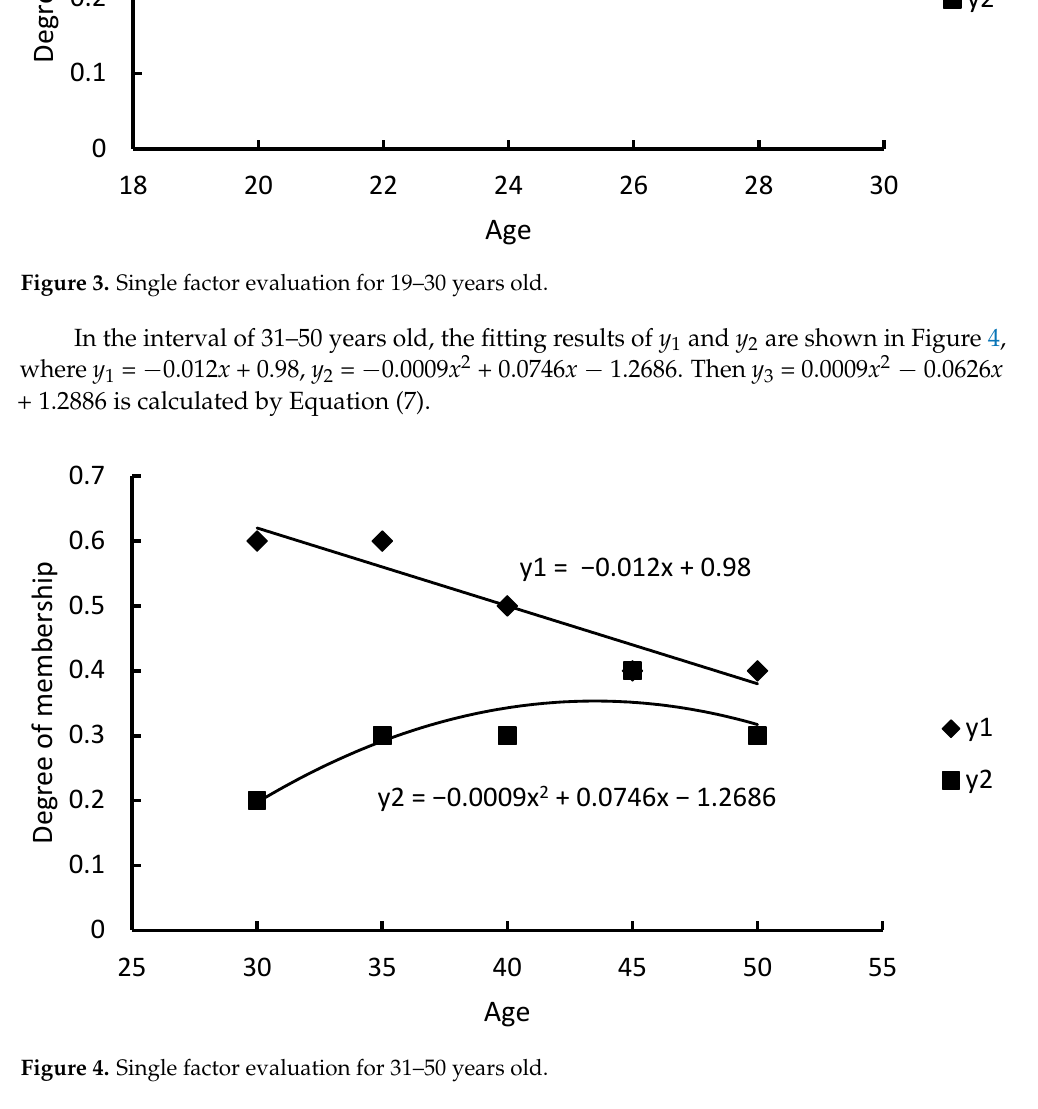
Figure 4. Single factor evaluation for 31–50 years old. In the interval of 51–60 years old, the fitting results of y 1 and y 2 are shown in Figure 5, where y 1 = − 0.0018 x 2 + 0.175 x − 3.8657, y 2 = 0.3. Then y 3 = 0.0018 x 2 − 0.175 x + 4.5657 is calculated by Equation